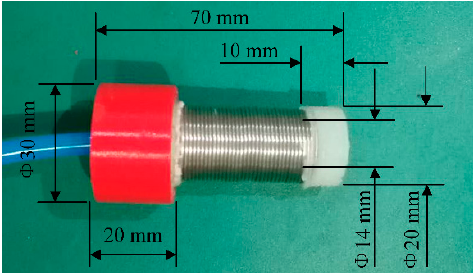
Figure 1. Design diagram of the soft-rigid gripper: ( a ) gripper actuated by a linear-extension soft pneumatic actuator; ( b ) schematic of the gripper.